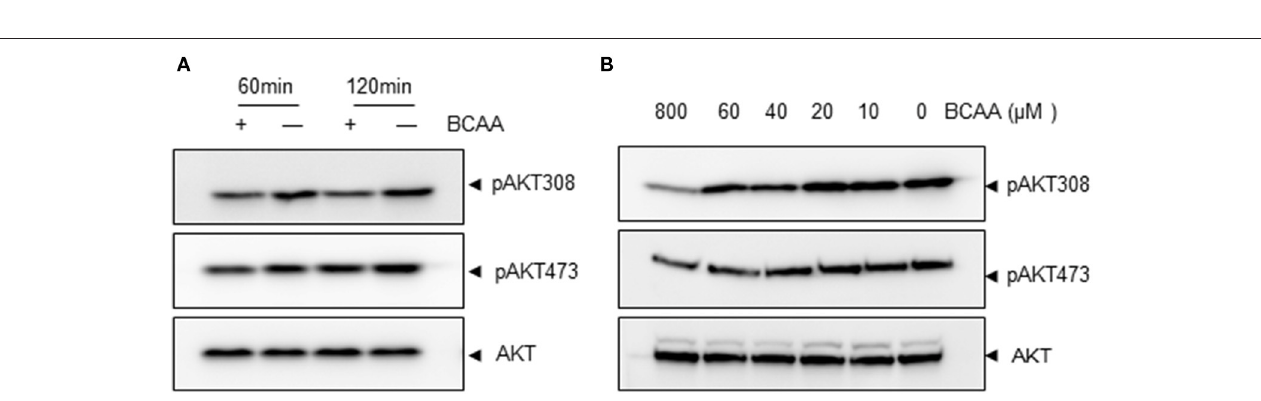
FIGURE 2 | BCAA but not their catabolites regulate KLF15 expression. (A,B) Quantitative PCR results of BCAT2 (A) or KLF15 (B) in MEFs with Bcat2 silencing using shRNA. (C) Quantitative PCR results of KLF15 in MEFs with Bcat2 silencing with or without BCKA (500 µ M) or 800 µ M BCAAs replenishment for 2h after 4-h BCAA starvation ( − ). * p < 0.05, ** p < 0.01.